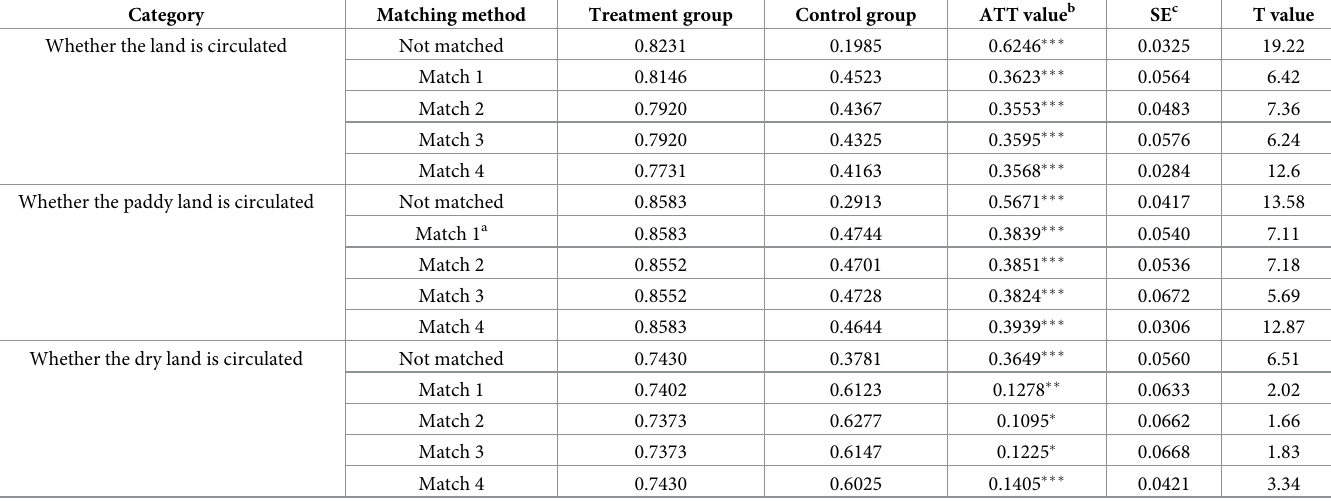
Table 2. PSM estimation results of agricultural planting structure by land circulation (dummy).